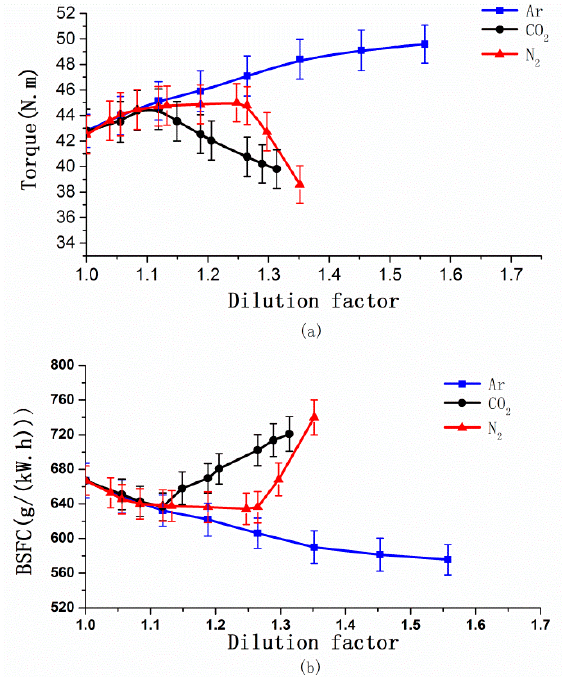
Figure 14. Variation in methanol consumption and torque vs. the DF of CO 2 , N 2 , and Ar.